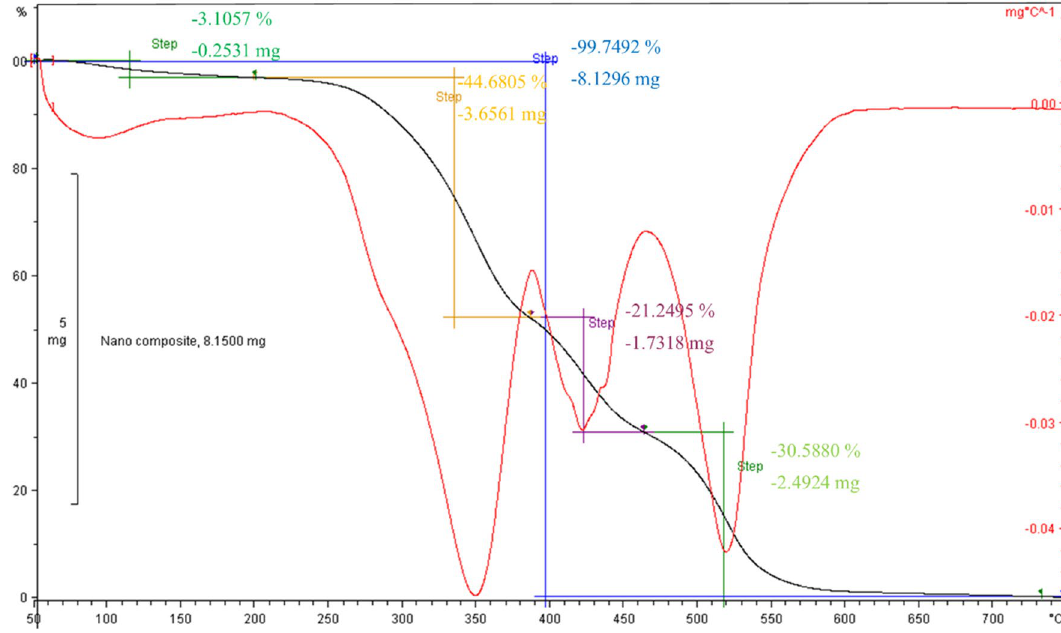
Figure 7. The quasi-static TGA ( −) and DTGA ( −) of the TiO 2 @PVA nanocomposite with corresponding step analysis and degradation